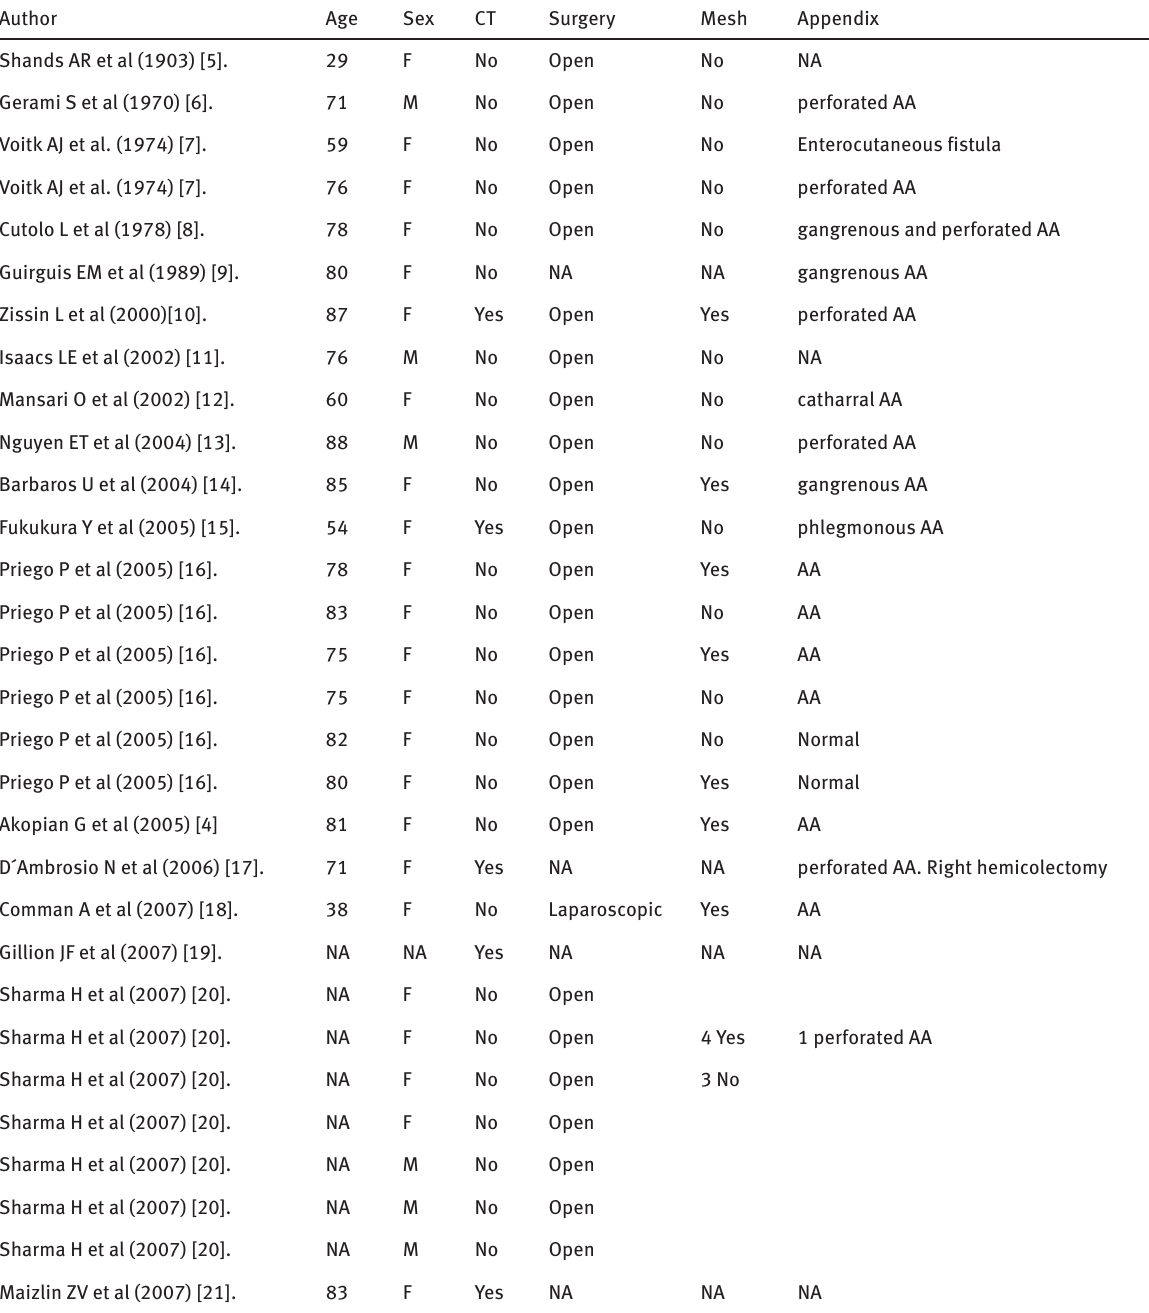
Table 1: Cumulative presentation of cases